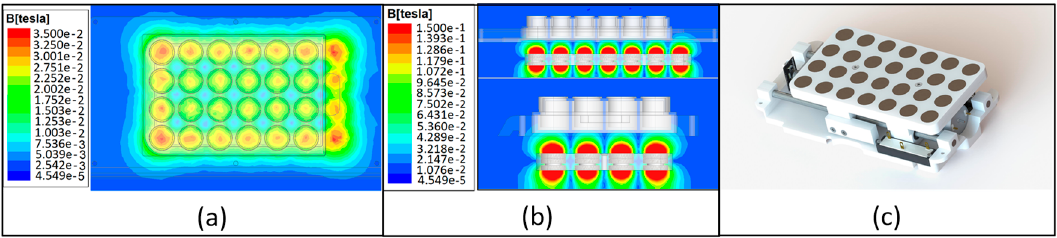
Figure 2. ( a ) Magnetic field intensity distribution at the bottom of 24-wells cell culture plates, ( b ) magnetic field force lines simulation in frontal and side planes and ( c ) rendered model of the mechanical permanent magnets table ball-screw assembly.